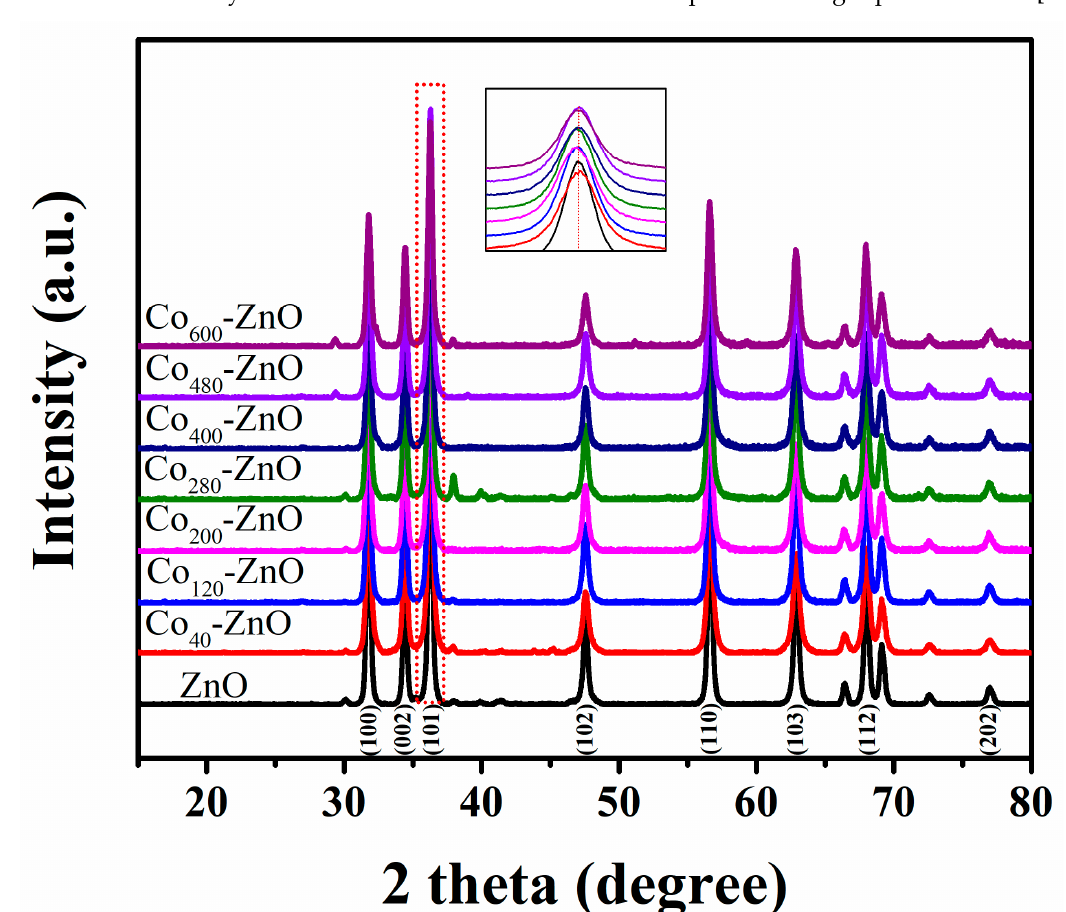
Figure 1. XRD patterns of ZnO and Co-ZnO.